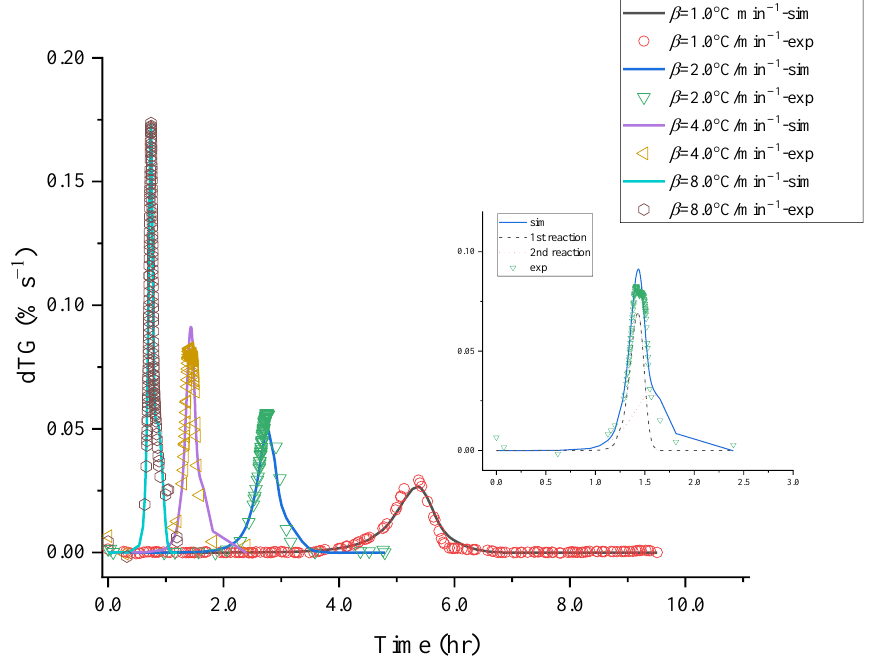
Figure 4. Comparisons of [BZMIM][TF2N] ’s mass loss (top) and mass loss rate (bottom) vs. time curves at heating rates of 1.0, 2.0, 4.0, and 8.0 °C min −1 by experiments and simulations. Table 1. Thermokinetics parameters evaluation for [BZMIM][TF2N] of the heating rates of 0.5, 1.0, 2.0, 4.0, and 8.0 °C min − 1 .